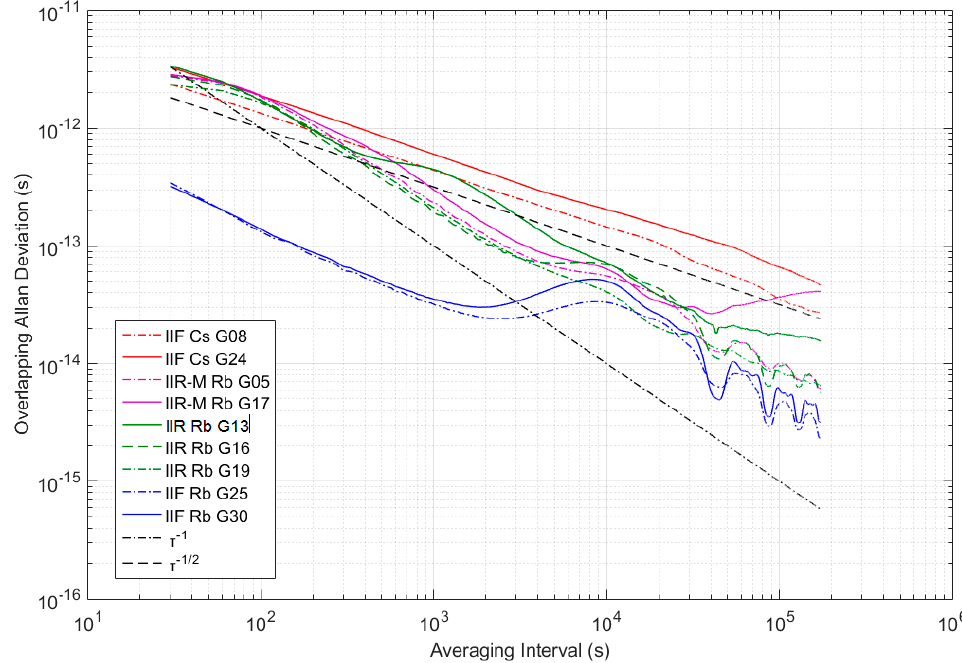
Figure 1. The Overlapping Allan DEViation (OADEV) for GPS on-board clocks over 30 days.